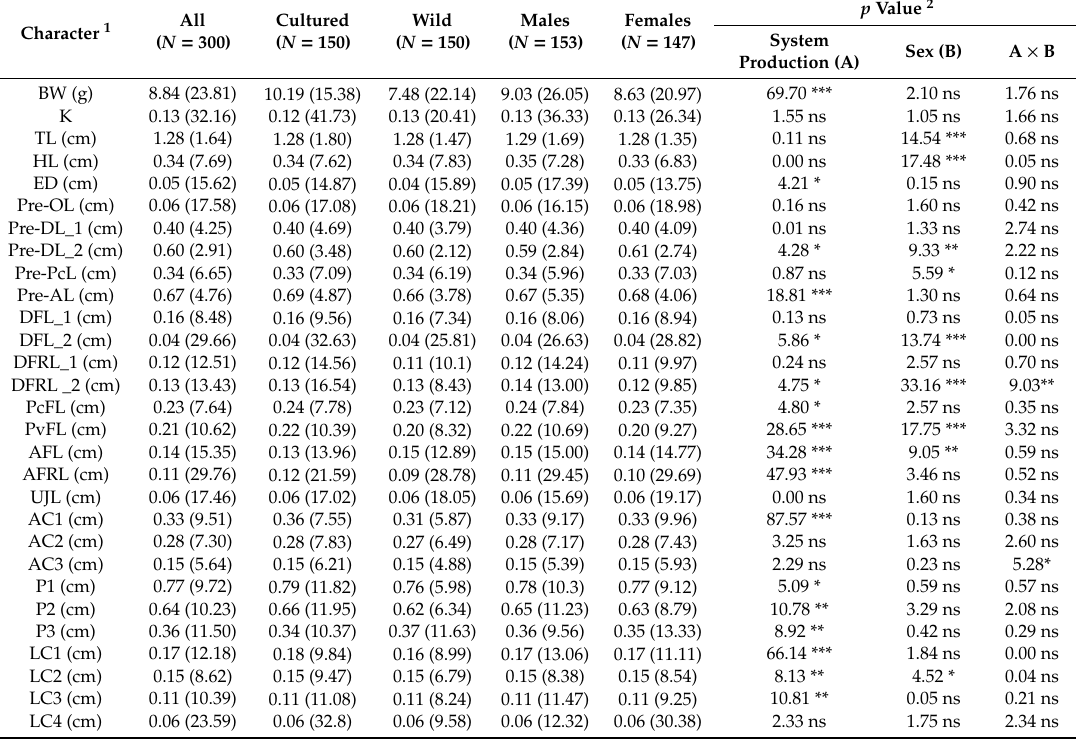
Table 5. Descriptive statistics of body measurements (adjusted data) of Dormitator latifrons from hatchery and wild populations for each sex (mean